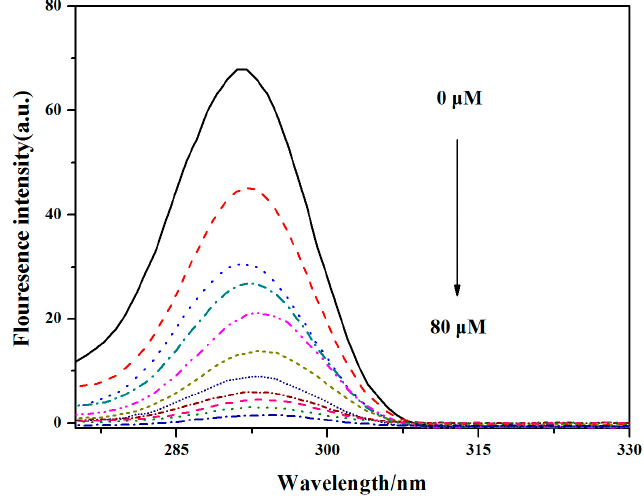
Figure 10. The fluorescence spectra of HSA (2 µ M) in the presence of different concentrations of V 18 (0, 8, 16, 24, 32, 40, 48, 56, 64, 72, 80 µ M) in PBS.